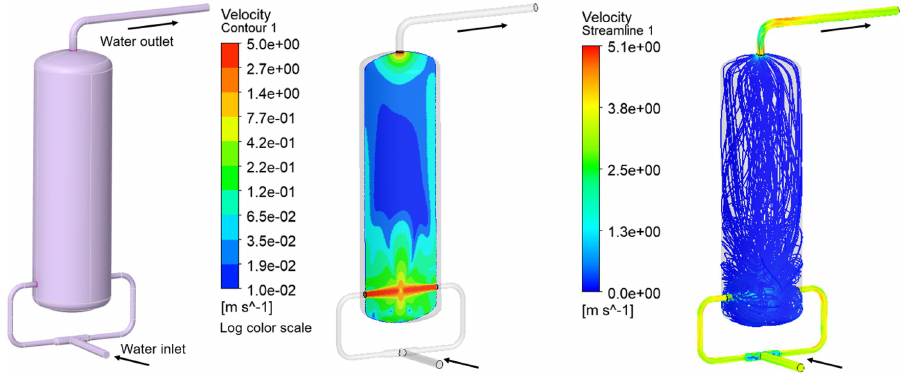
Figure 11. Velocity profile of activated water inside the delay